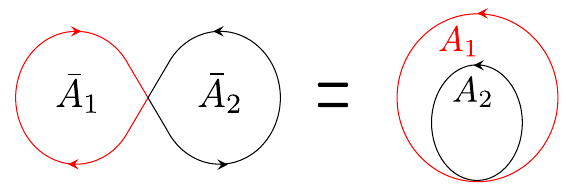
Figure 9 . The (cid:12)gure eight loop and the one-intersection loop. On S 2 , one can continuously deform one to the other. In the right (cid:12)gure, the areas of the outer and inner circles are denoted by A 1 ; 2 respectively. The areas are related by A 1 = 4 (cid:25) (cid:0) (cid:22) A 1 and A 2 = (cid:22) A 2